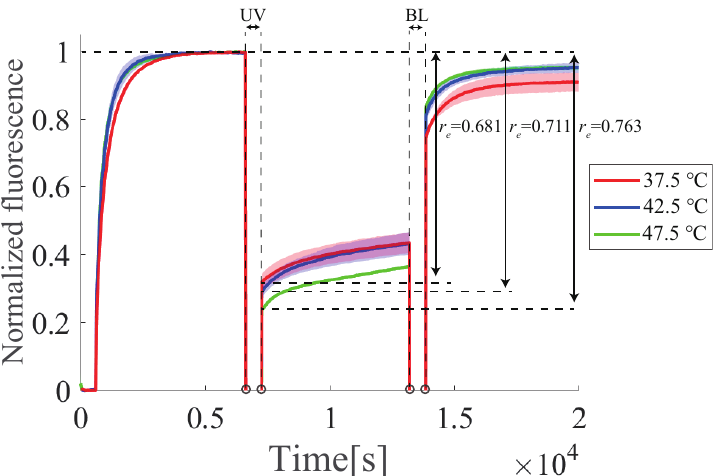
Figure 12. Effect of changing the temperature on azobenzene. The red line is 37.5 ◦ C, the blue line is 42.5 ◦ C, and the green line is 47.5 ◦ C. This result is the average of three times. Colored areas represent the standard deviations.